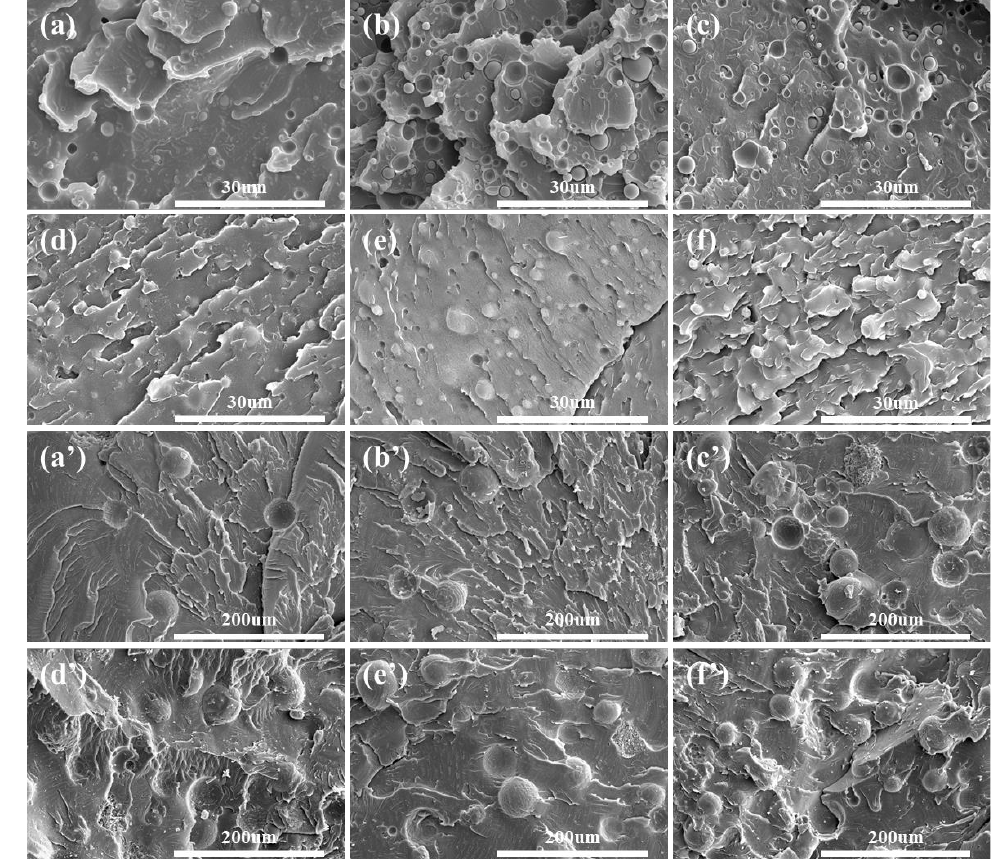
Figure 2. SEM images of PC/A S composites: ( a ) PC/A S 10, ( b ) PC/A S 20, ( c ) PC/A S 30, ( d ) PC/A S 40, ( e ) PC/A S 50, and ( f ) PC/A S 60. SEM images of PC/A L composites: ( a’ ) PC/A L 10, ( b’ ) PC/A L 20, ( c’ ) PC/A L 30, ( d’ ) PC/A L 40, ( e’ ) PC/A L 50, and ( f’ ) PC/A L 60.